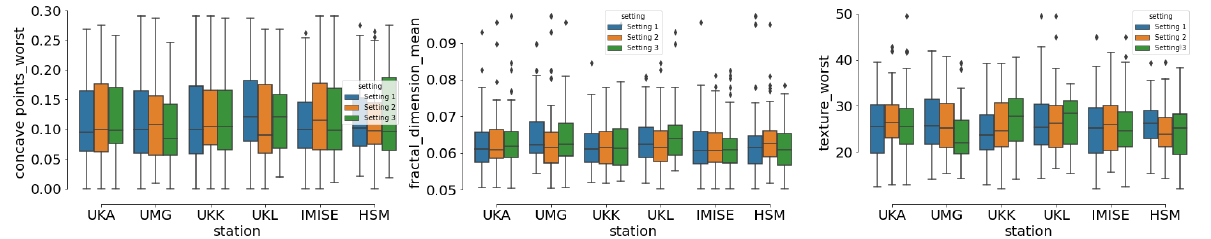
Figure 7. Feature distributions of the three principal components concave points_worst , fractal_dimension_mean , and texture_worst over six institutions (UKA, UKK, UKL, UMG, HSM, IMISE). In our experiments, we evaluated the model performance in distribution settings: ( Set- ting 1 ) equally-sized and balanced class distribution, ( Setting 2 ) equally-sized and unbalanced class distribution, and ( Setting 3 ) unequally-sized and unbalanced class